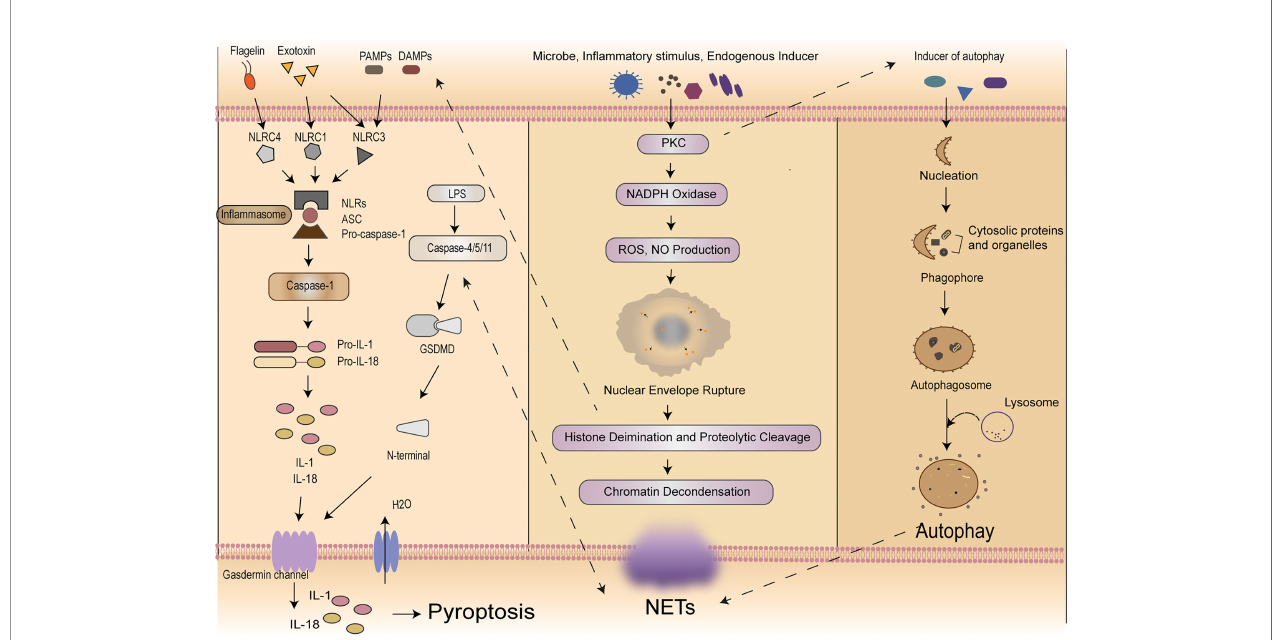
FIGURE 1 | Mechanisms of self-sacri fi ce in neutrophils. Pyroptosis mainly relies on in fl ammasome to activate caspase family, caspase family could cleave and activate gasdermin protein, which is transferred to the membrane to form holes and thus leads to cell membrane rupture. NETs components DNA and histones can act as DAMPs molecules to directly initiate or amplify in fl ammatory responses. NETosis induced by LPS in neutrophils can elicit caspase-11 and GSDMD-dependent histone H3 citrullination. NETosis is a multi-step process involving the destruction of neutrophil nuclear and cytoplasmic granular membranes, chromatin relaxation, chromatin interaction with granular proteins, and chromatin release from the cells. A variety of stimulants, such as PMA, micro fl ora, LPS, eubacteria, activated blood plates, IL-8 and immune complexes, can induce the formation of NETs through the PKC signaling pathway. Autophagy is a process enveloping bacteria and viruses escaped from the phagosomes or damaged mitochondria into vesicles, fusing with lysosomes to form autophagosomes and degrading their encapsulated contents. Neutrophil autophagy could subsequently activate NETs. NETs, neutrophil extracellular traps; DAMPs, damage ‐ associated molecular patterns; LPS, lipopolysaccharide; GSDMD, gasdermin D; PMA, phosphor myristate; IL, interleukin; PKC, protein kinase